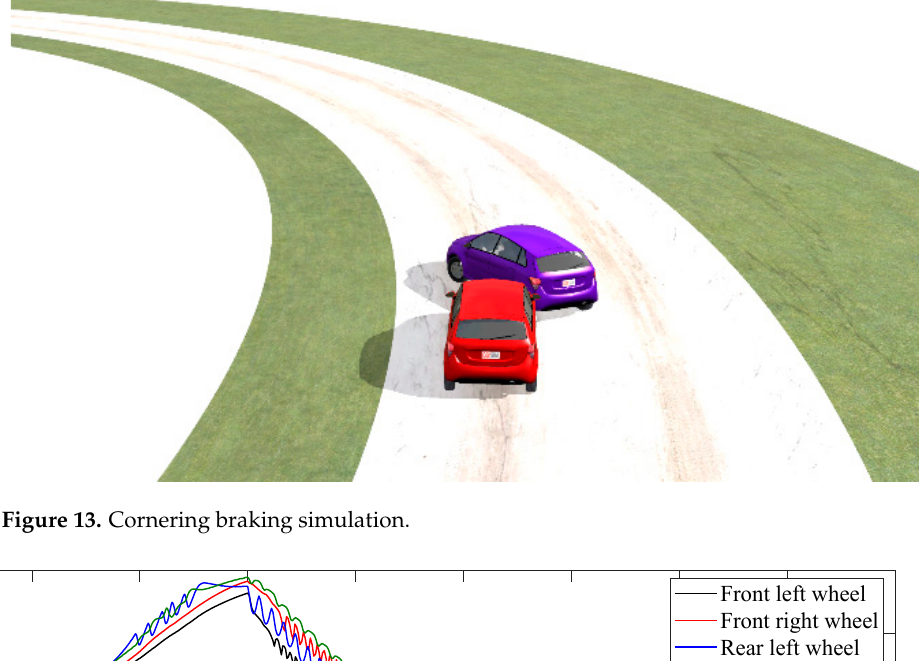
Figure 13. Cornering braking simulation.